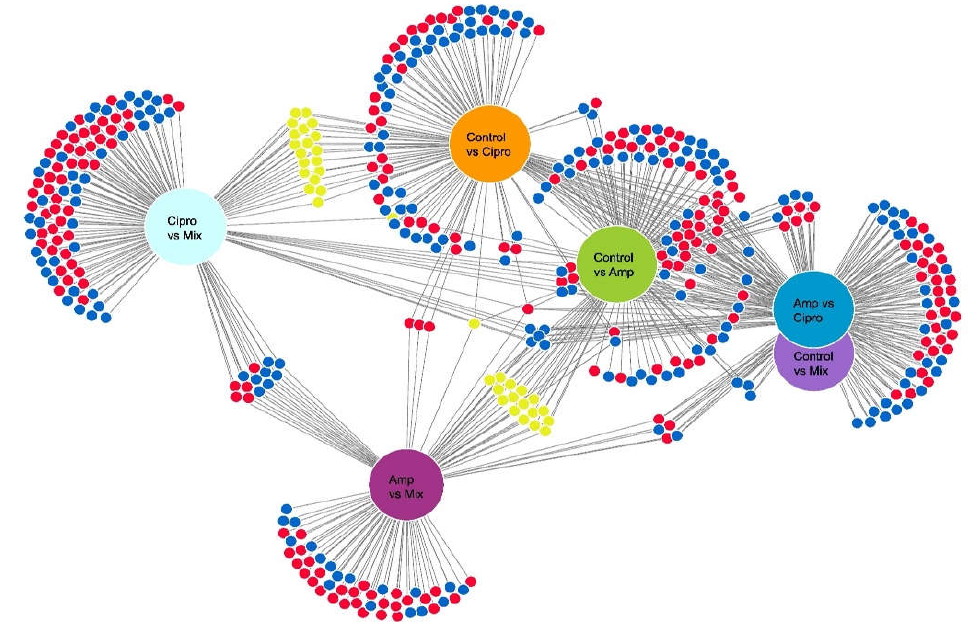
Figure 3. Venn diagram showing the number of differentially expressed genes in the mycobiont of Lobaria pulmonaria , identified by pairwise Wald test comparisons for antibiotic treatments. Downregulated: blue, upregulated: red, up/downregulated: yellow circles. Thresholds for inclusion were log 2 -fold change (>1.5=upregulated; < − 1.5=downregulated) and Benjamini–Hochberg adjusted p -value ( p < 0.05).